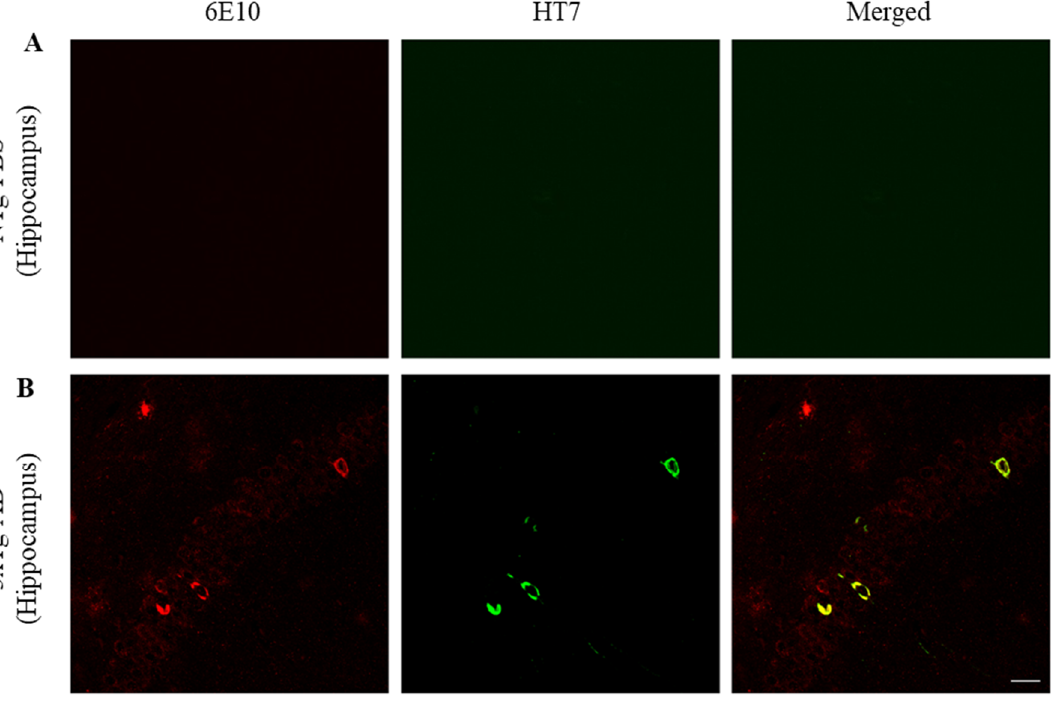
Figure 3. NTFs co-localize within A β -containing neurons in CA1 of the hippocampus. ( A ) On the left A β in red (6E10), in the center tau in green (HT7), and on the right A β / tau merged. Labeling in the hippocampus of an untreated NTg mouse to determine the background noise. ( B ) Labeling in 3xTg-AD hippocampus. Scale bar, 25 µm.